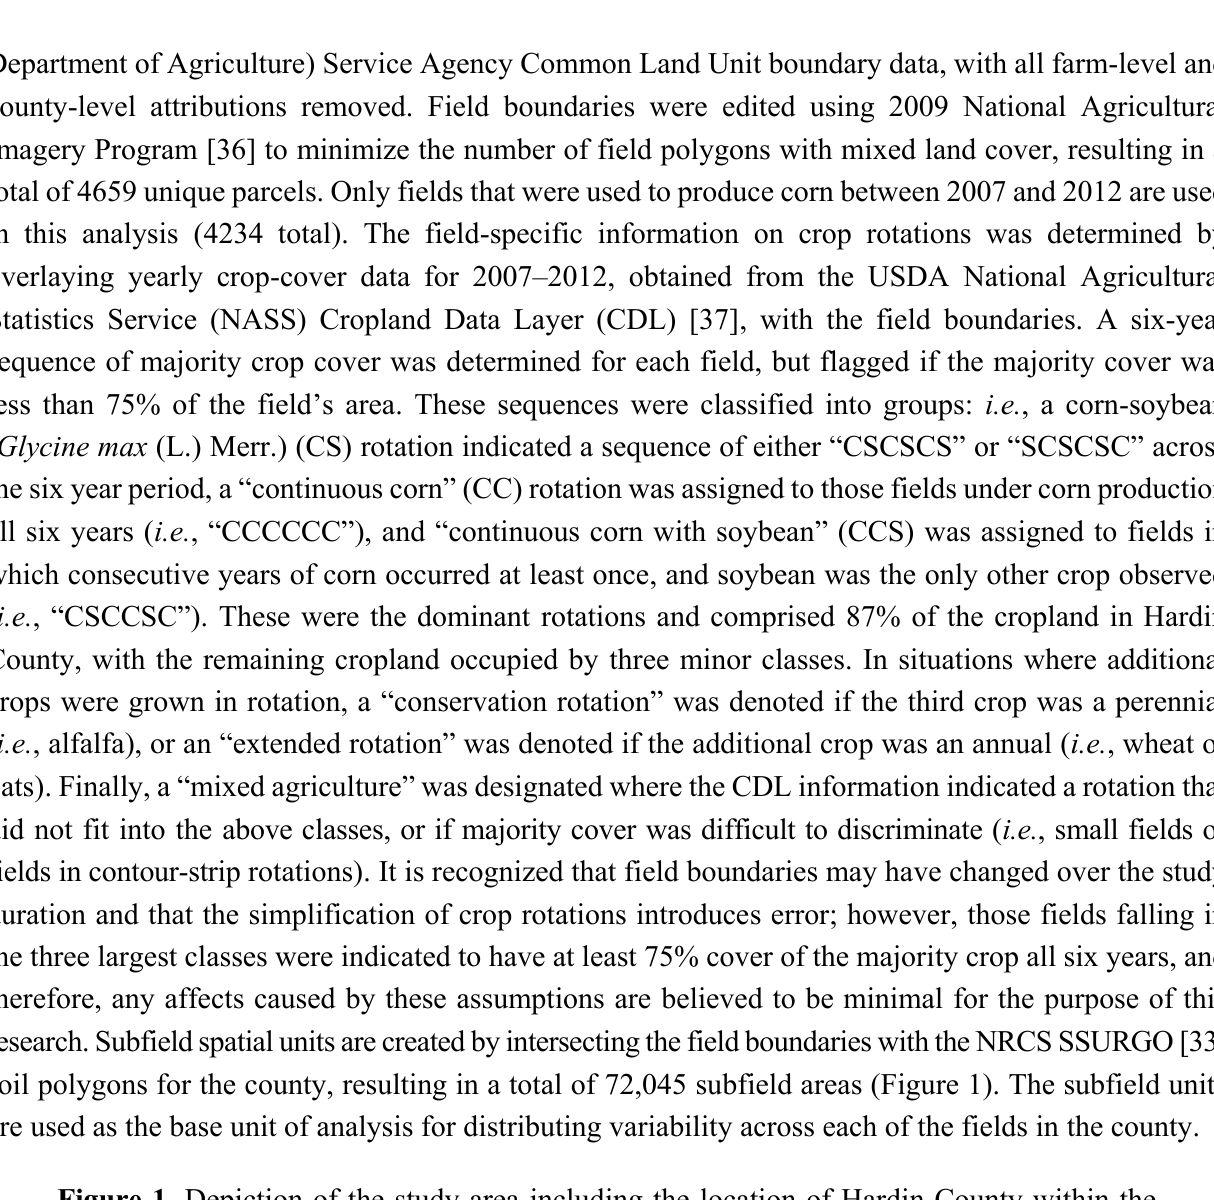
Figure 1. Depiction of the study area including the location of Hardin County within the state of Iowa ( left ); each of the field boundaries within the county ( center ); and subfield soil polygons within each field ( right